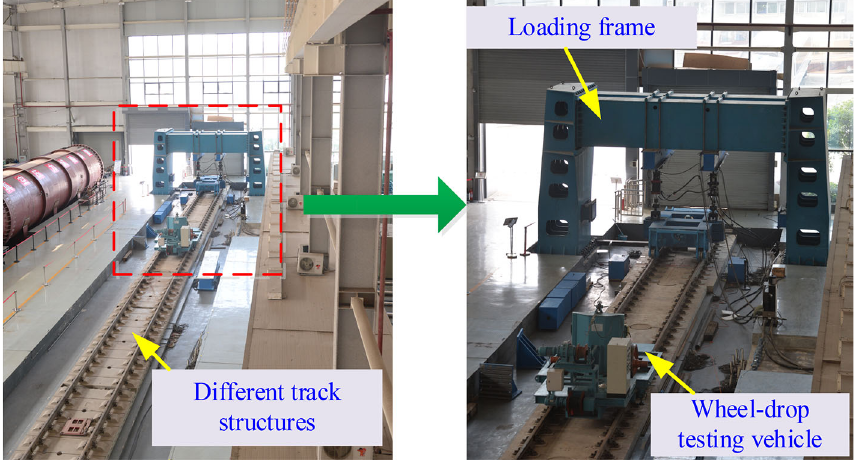
Fig. 14 HTST test platform for track–subgrade systems of high-speed